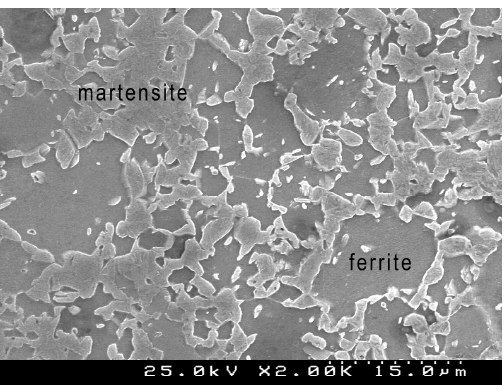
Figure 1. Microstructure observation of dual-phase DP1000 steel used.